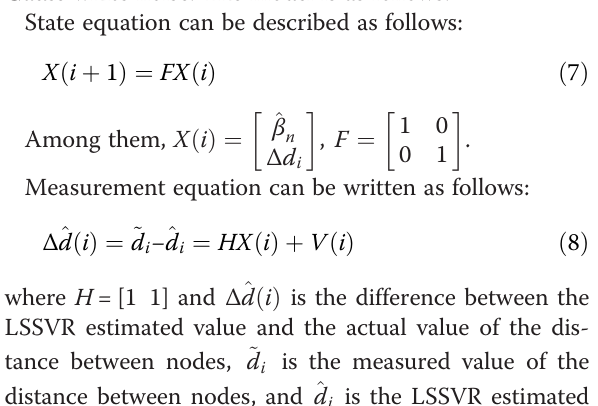
algorithm, a three-dimensional localization algorithm